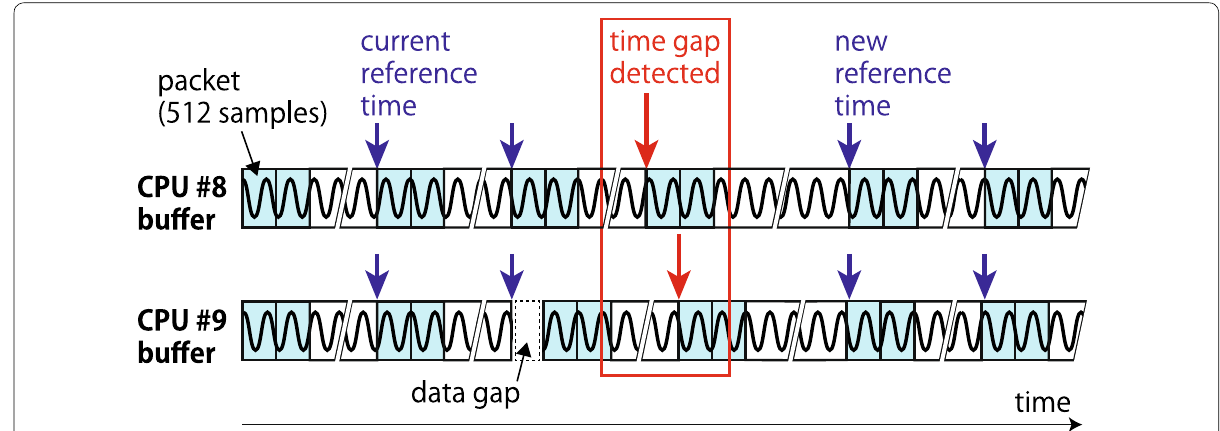
Fig. 3 A schematic diagram of the signal buffers on the each CPU